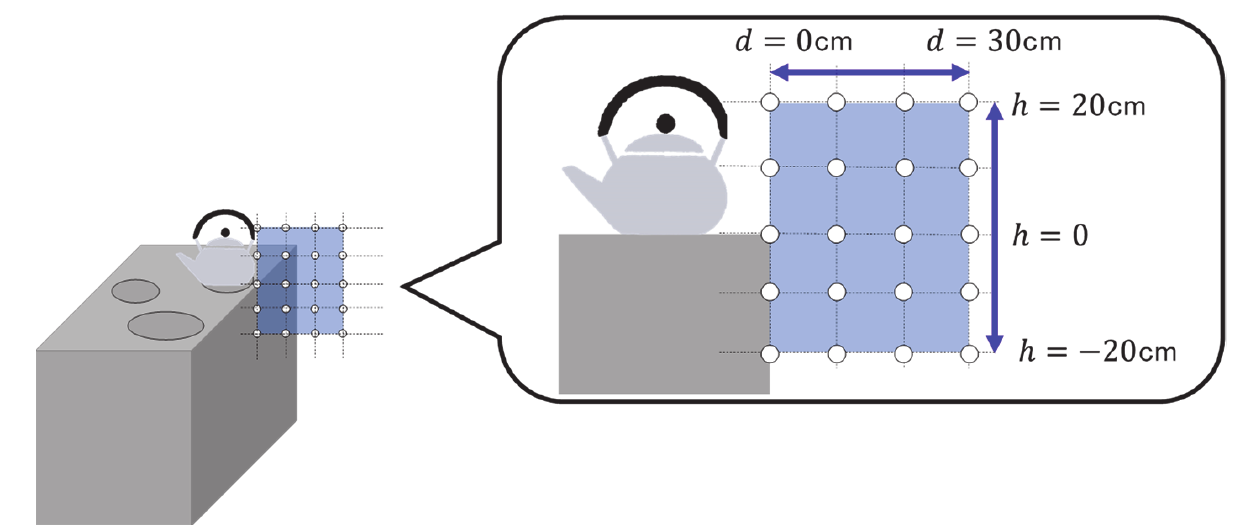
Figure 1. Schematic diagram of magnetic field measurement points in Phase 1 household environment measurement, based on the measurement method of IEC 62233; the number of measurement points was set at 20 to provide a measurement point where a woman’s pelvis fits and to take into account various cooking postures. The enclosure plane is defined as the height reference ( h = 0), and the edge of the enclosure (Edge) is defined as d = 0.